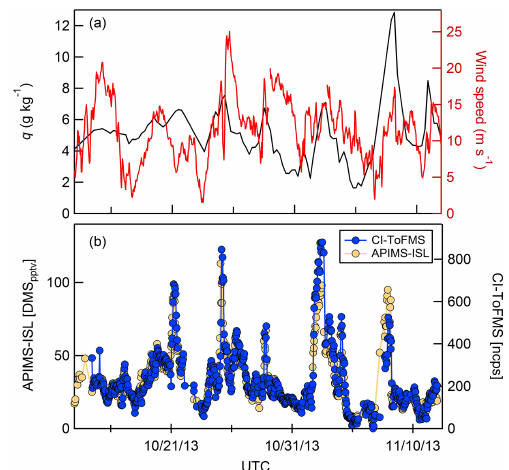
Figure 12. Hourly measurements from the High Wind Gas Ex- change Study (HiWinGS) research cruise. Normalized CI-ToFMS count rates compared well ( R 2 = 0.80, hourly averages during en- tire campaign) with dimethyl sulfide mixing ratios measured by the University of Hawaii’s APIMS-ILS. No corrections were made for ambient